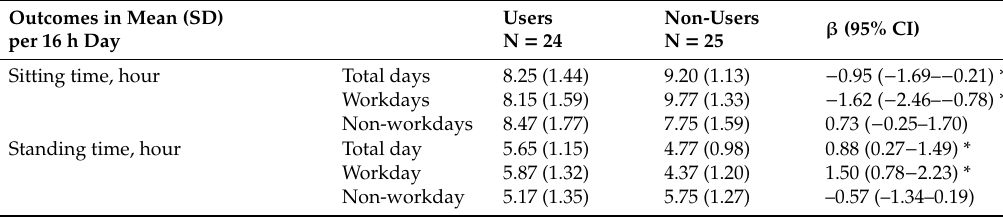
Table 3. Movement behaviour outcomes for total days, workdays and non-workdays and differences between users and non-users ( β ), including 95% confidence intervals (95% CI). Outcomes in Mean (SD) per 16 h